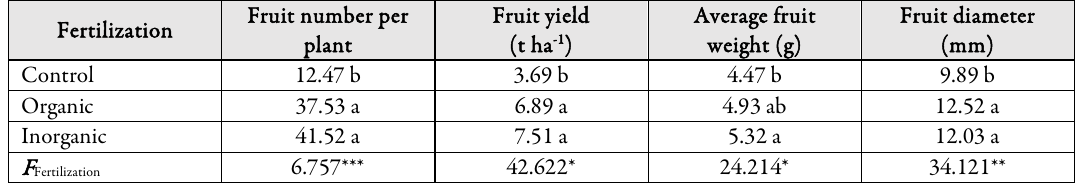
Table 3. Fruit number per plant, fruit yield, average fruit weight and fruit diameter of P. peruviana as affected by fertilization Fruit number per Fruit yield Average fruit Fruit diameter Fertilization plant (t ha -1 ) weight (g) (mm) Control 12.47 b 3.69 b 4.47 b 9.89 b Organic 37.53 a 6.89 a 4.93 ab 12.52 a Inorganic 41.52 a 7.51 a 5.32 a 12.03 a F Fertilization 6.757*** 42.622* 24.214*